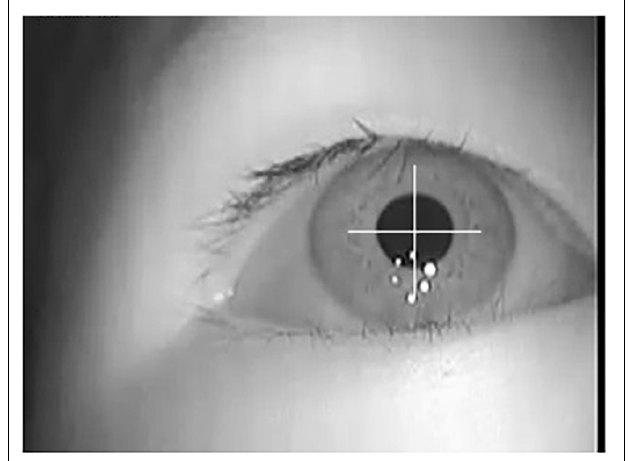
FIGURE 3 | Pupil extraction of eye movement